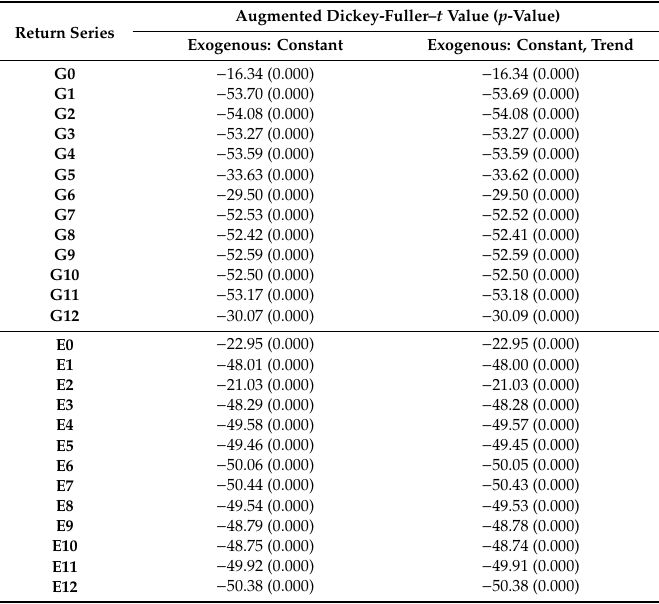
Table 2. Unit root